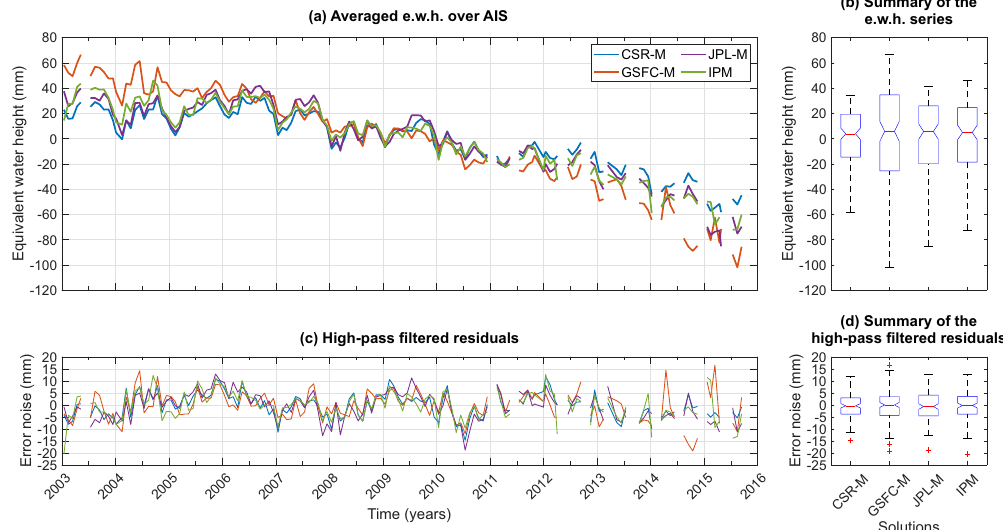
Figure 6. ( a ) The areal-weighted average time series of mass changes for the AIS for the different solutions expressed as equivalent water height (e.w.h.) in mm. ( b ) The box plots summaries of e.w.h. series in panel ( a ) at which the whiskers indicate the maximum and minimum range of e.w.h. ( c ) Time series of the error noise defined as the residuals of the de-trended and de-seasoned series minus low-pass filtered residuals (i.e., the high-pass filtered residuals). ( d ) The same as panel ( b ), however, for the error noises. The boxes show the interquartile (first and third quartile) ranges of variation of the values, the segments inside the respective boxes sow the median of the values, and the crosses indicate the